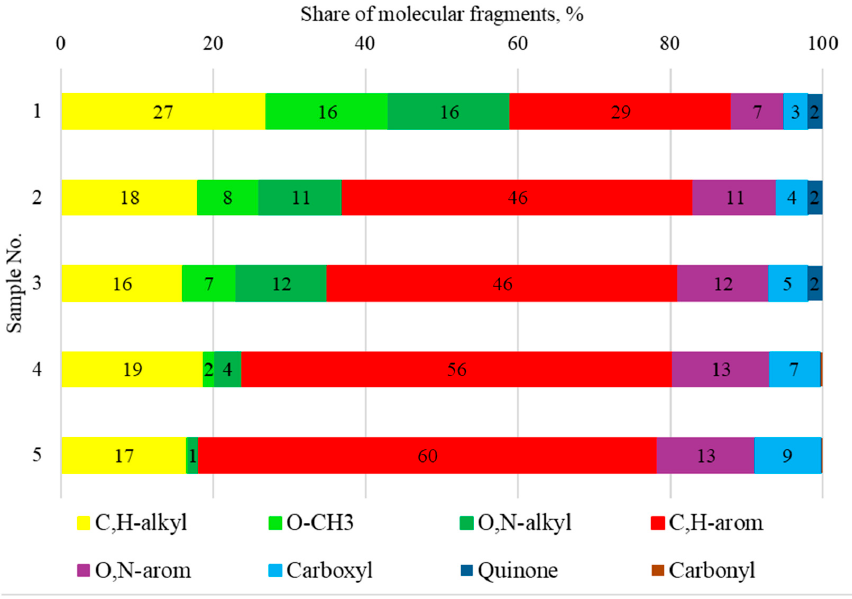
Figure 4. The molecular composition of HAs isolated from studied soils. Sample No. corresponds to Table 1: 1—Control; 2—Crown fire, 2010; 3—Surface fire, 2010; 4—Crown fire, 2020; 5—Surface fire, 2020.